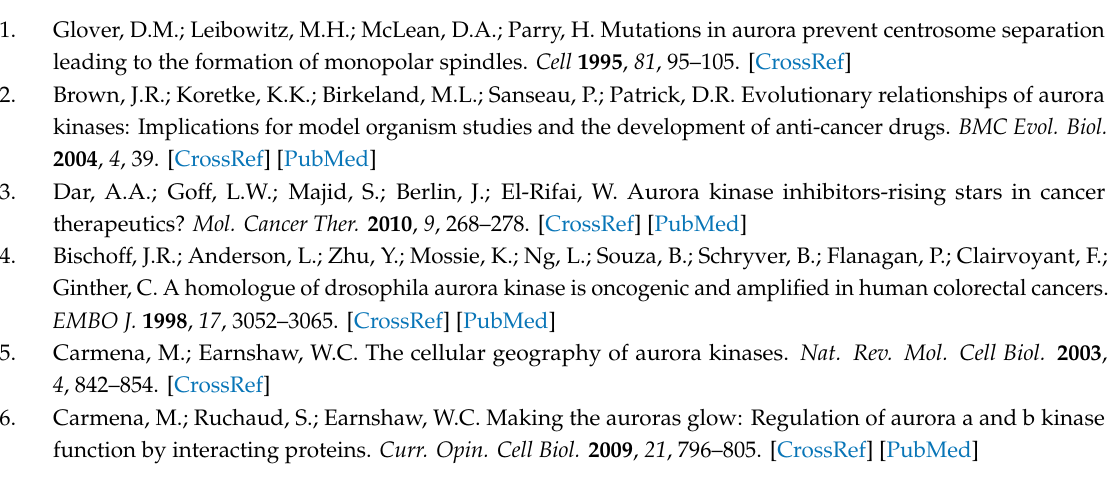
Supplementary Materials: The following are available online, Table S1: The structures of the seventy-nine Aurora-A Kinase inhibitors collected from the (ChEMBL), utilized in modeling. Table S2: Refinement list for steric refinement of Hypo(SB-1). Table S3: The 75 high-ranking hits captured by Refined-Hypo(SB-1) 3D search query-obtained from NCI and their anti-Aurora-A kinase inhibition % at 10 µ M using Z (cid:48) -LYTE ® kinase assay (Invitrogen, Carlsbad, CA, USA), sum of their critical contacts and their predicted activity. Section S1: LibDock Docking Engine and Scoring Settings. Section S2: Scoring of Docked Ligand Poses. Section S3: Genetic Algorithm Implementation in dbCICA Modeling. Section S4: receiver operating characteristic (ROC) curve analysis. Section S5: Steric Refinement of pharmacophores. Figure S1: Three-dimensional plot showing three main principal components calculated for the Testing Set of for HIPHOP REFINE modeling. Figure S2: The chemical structures of the tested highest-ranking hits. Figures S3–S10: “NMR” and Mass Spectrum for Hit 88 (NCI 1576). Figure S11–S18: “NMR” and Mass Spectrum for Hit 130 (NCI 12849). Figures S19–S25: “NMR” and Mass Spectrum for Hit 85 (NCI 14040), Figures S26–S32: “NMR” and Mass Spectrum for Hit 112 (NCI 12415). Figures S33–S38: “NMR” and Mass Spectrum for Hit 141(NCI